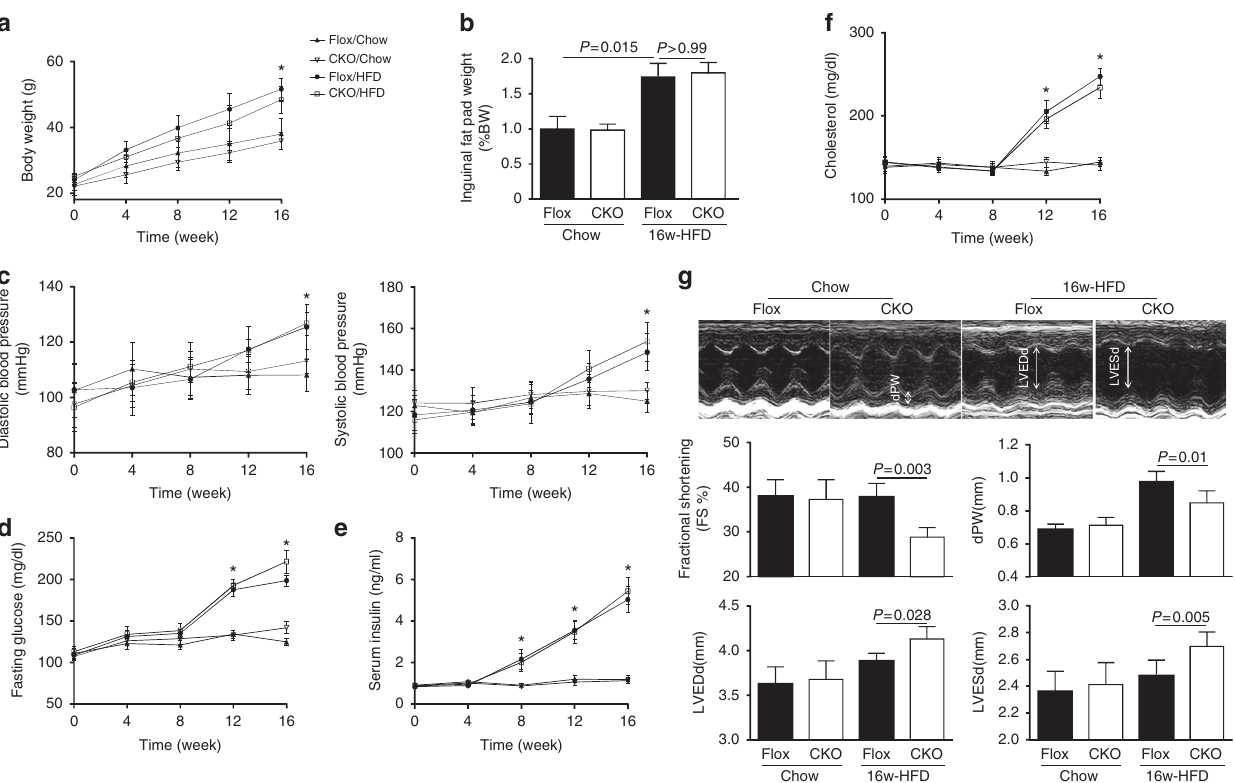
Fig. 2 Impaired cardiac function in CKO mice with 16-week HFD. a Body weights of Flox and CKO mice fed with chow diet or HFD were recorded at 4-week intervals. (* P < 0.05, vs. chow groups, n = 11 mice per group). b Quantitative analysis of inguinal fat-pad mass. ( n = 6 mice per group). c Diastolic and systolic blood pressure, d fasting blood glucose, e insulin, and f cholesterol were gradually increased with HFD for 16 weeks in both Flox and CKO mice. * P < 0.05, vs. chow groups, n = 9 mice per group. g Echocardiographic assessment of FS%, dPW, LVEDd, and LVESd by M-mode images and quanti fi cation demonstrated the impaired cardiac function in HFD-CKO mice. n = 12 mice per group. Data are presented as means ±